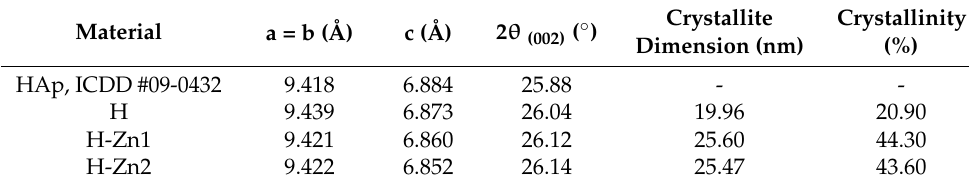
Table 3. Lattice parameters, crystallite dimension and crystallinity of the